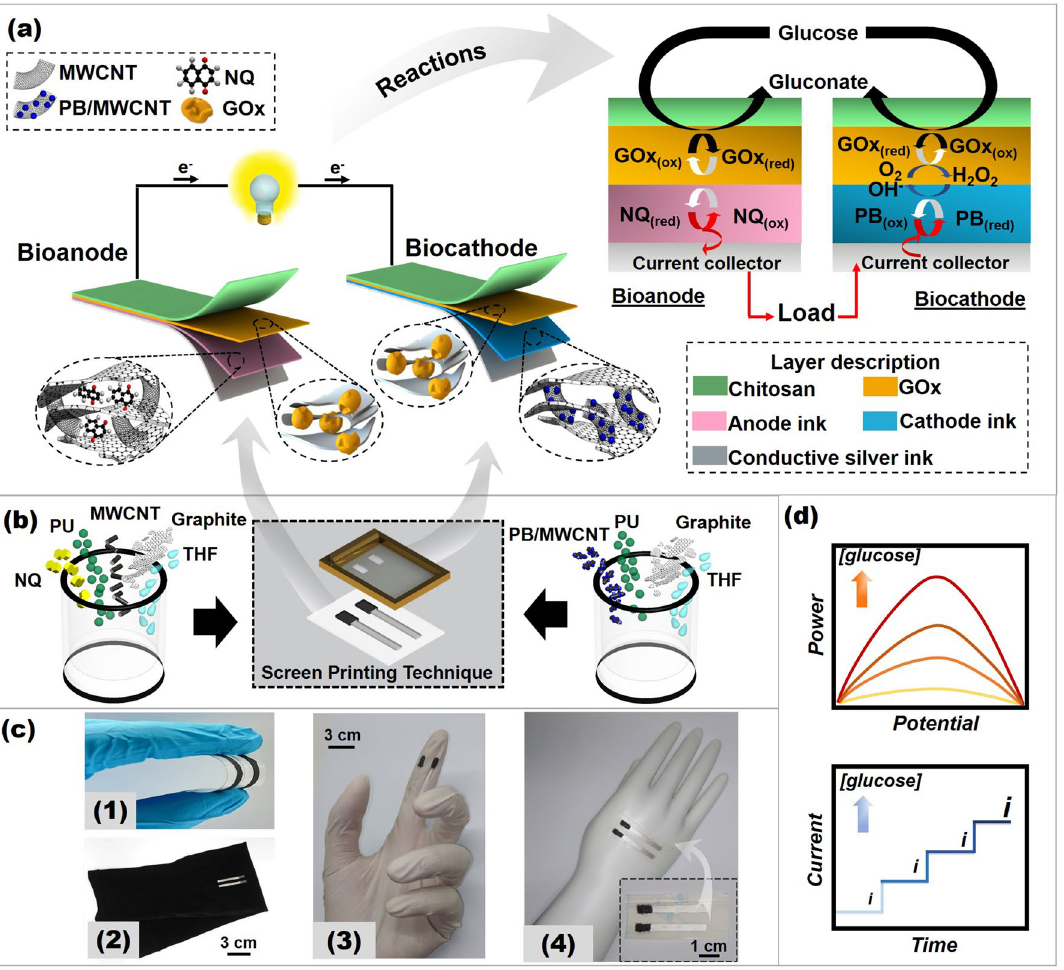
Fig. 1 The conceptual presentation of a screen-printed and flexible single-enzyme-based system for harvesting energy from glucose and self- powered sensing glucose. a The components of a screen-printed glucose BFC along with redox reactions occurring on the bioanode and the bio- cathode. b Preparation of the screen-printable inks for the anode and the cathode. c Photographs of a screen-printed glucose BFC on (1) PET, (2) a stretchable textile (arm sleeve), (3) a glove (fingertip), and (4) a stretchable epidermal tattoo attached to a hand model. d The working opera- tion of a screen-printed glucose BFC on (top and bottom) energy-harvesting and self-powered sensing